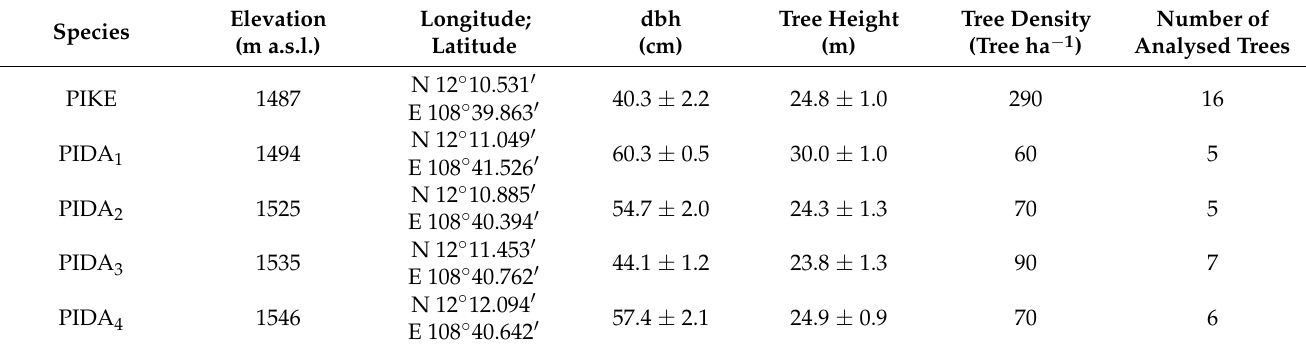
Table 1. Site and stand description of the study plots with different Pinus species. Tree density refers to all the particular Pinus trees growing on 1 ha. DBH, stem diameter at breast height. PIKE , Pinus kesiya; PIDA , Pinus dalatensis . Elevation Species (m